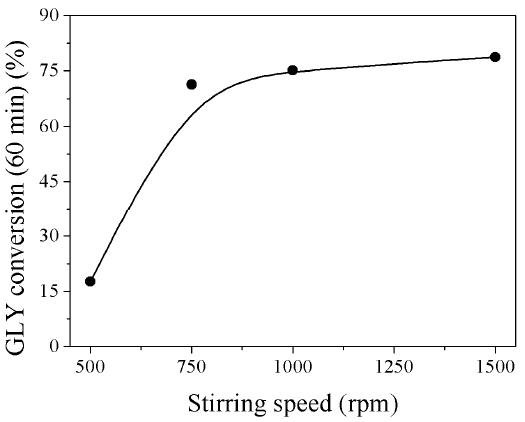
Figure 1. Conversion/t-profile of the glycerol (GLY) oxidation at different stirring speeds. Reaction conditions: C 0GLY = 0.3 mol/L, T = 60 °C, pO 2 = 5 bar, GLY/Au = 3500 mol/mol, NaOH/GLY = 4 mol/mol.